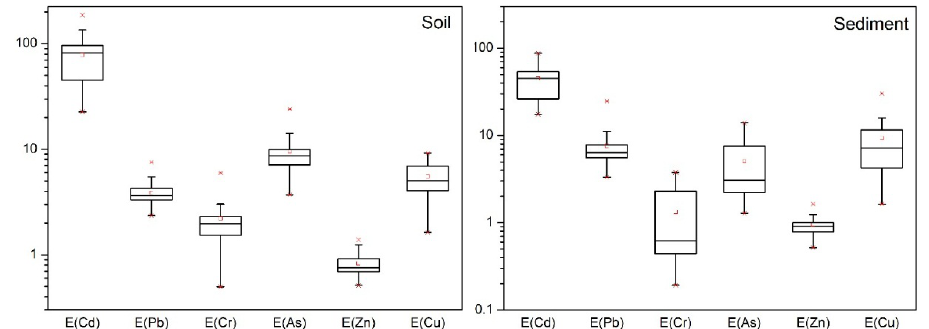
Figure 4. The EI values of the potentially toxic elements in soil and sediment (The upper × indicates 95th percentile and the lower × indicates 5th percentile value, respectively □ indicate median value).